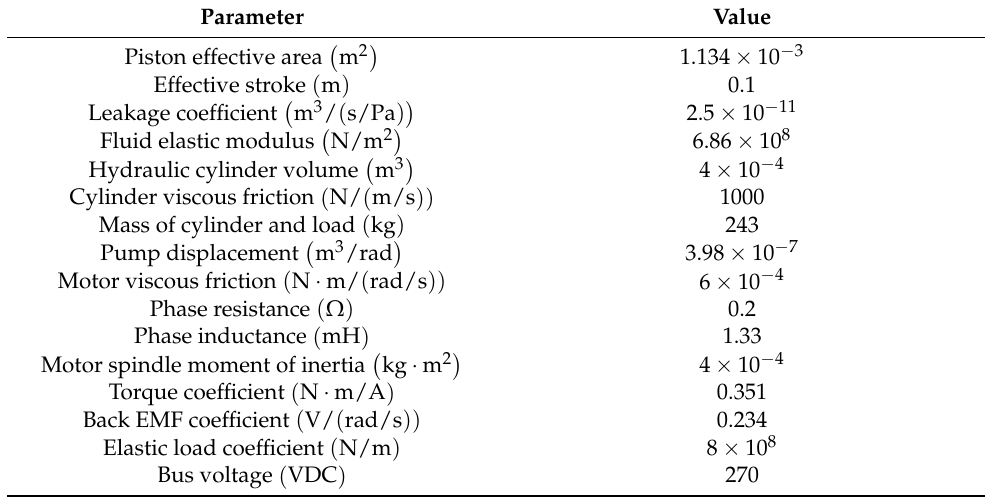
Table 1. Specifications for simulation